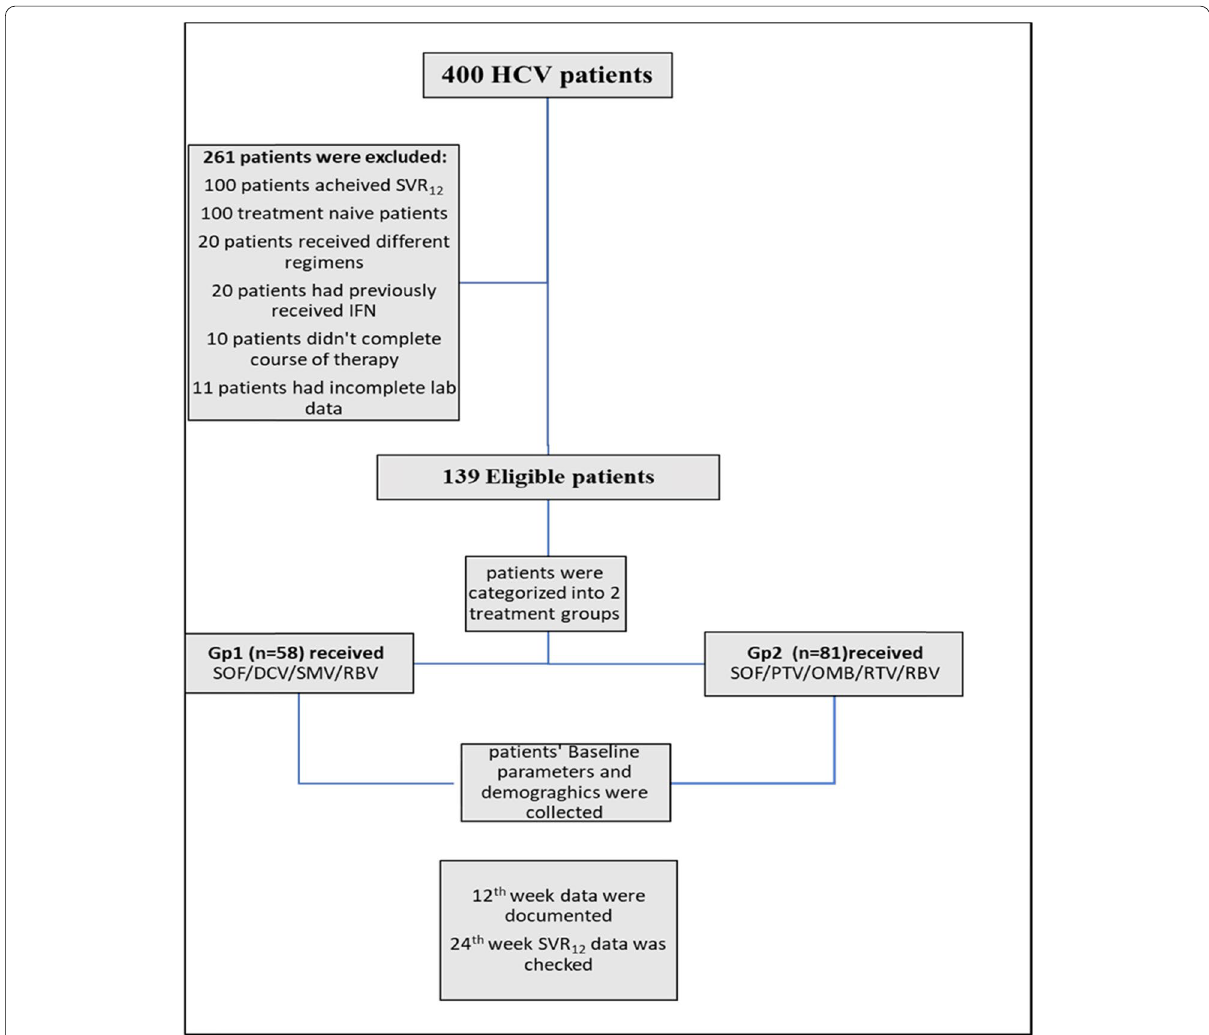
Fig. 1 Flow chart of patients’ recruitment and enrolment in the study. SVR 12 , sustained virological response; IFN, interferon; SOF, sofosbuvir; DCV, daclatasvir; SMV, simeprevir; RBV, ribavirin; PTV, paritaprevir; OMB, ombitasvir; RTV, ritonavir, Gp, treatment